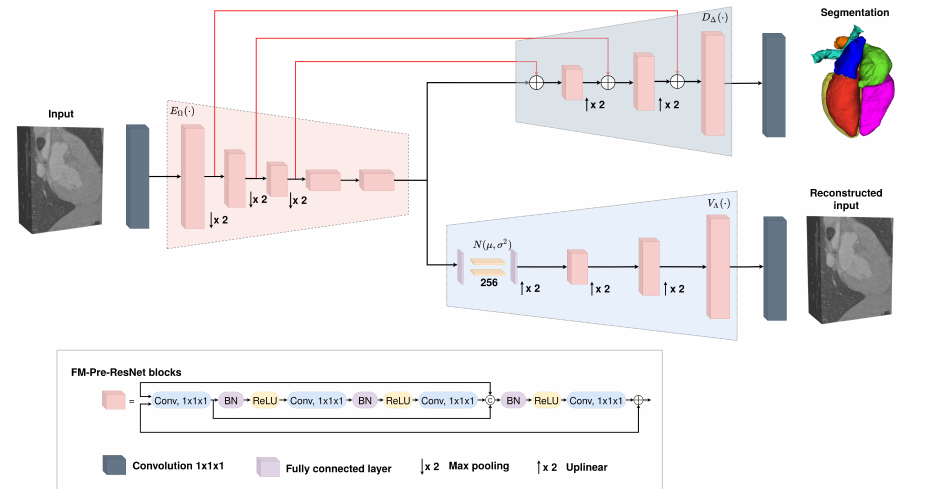
Figure 1. An illustration of proposed network architecture for the 3D whole heart segmentation. Input is a volumetric CT or MRI image. Each red block is the FM-Pre-ResNet block. The VAE branch is added at encoders’ output and is used only during training. The decoder stage creates the final whole heart